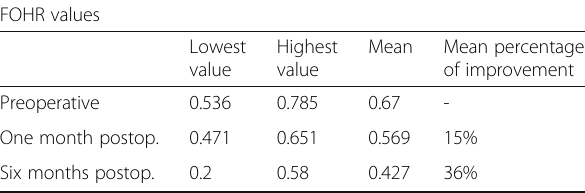
Table 1 Presentation of hydrocephalic children in our study Presenting symptoms